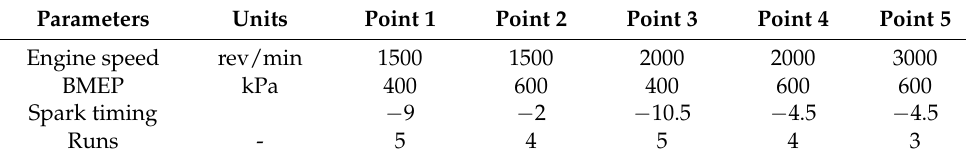
Table 4. Target engine speed and brake mean effective pressure of the 2nd